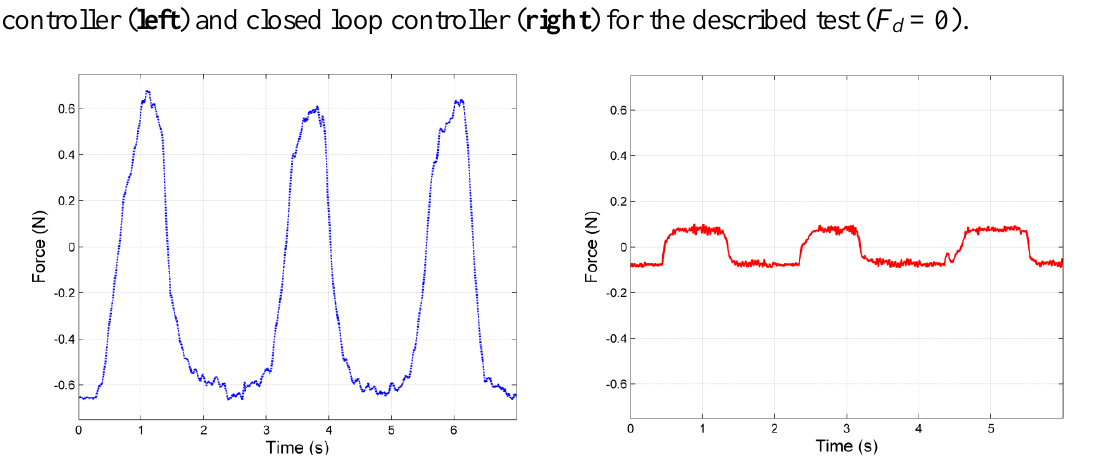
Figure 16. Comparison between the residual uncompensated force for the open loop controller ( left ) and closed loop controller ( right ) for the described test ( F